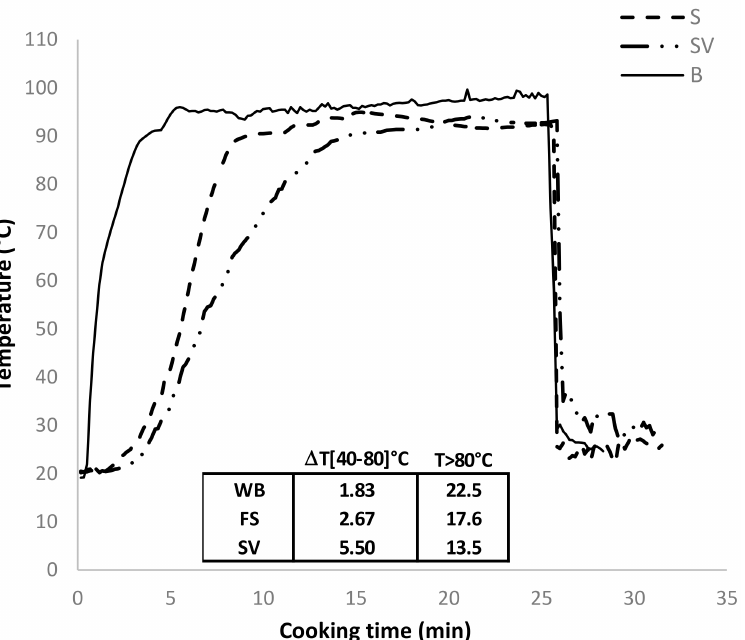
Figure 6. Time-temperature profiles under 25 min of steaming (S) and sous-vide (SV), and boil- ing (B), of Cheddar cauliflower. The inset shows the minutes of heating experienced from 40 to 80 ◦ C (optimum range for pectinmethylesterases activity) and beyond 80 ◦ C (deactivating of pectin-